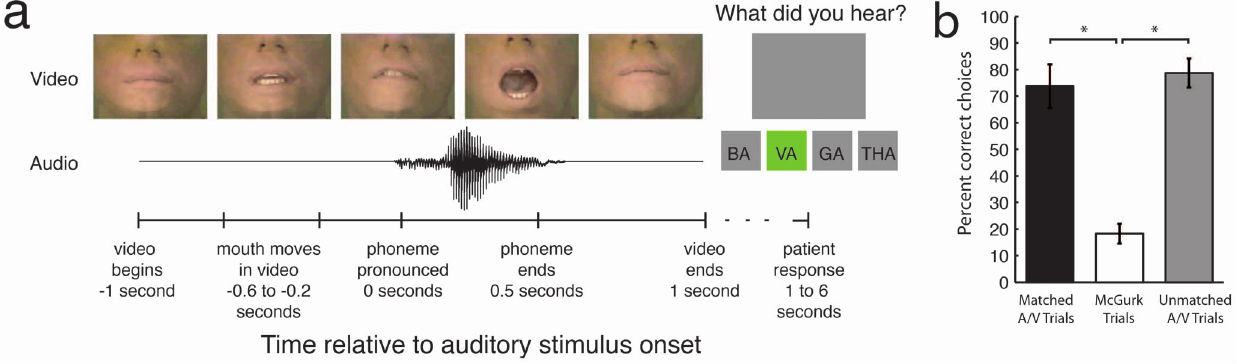
Figure 1. Task description and performance. a, The task consisted of a video of a mouth pronouncing one of four phonemes. This video was randomly paired with audio of a male pronouncing one of the same four syllables. The video times here are shown in the text below the timeline. There was one second of video before the audio began, during which the mouth moved slightly in order to position to speak the starting phoneme. The audio syllable lasted half a second, and there was one second of video after the audio had finished. After a brief randomized delay, the subject was cued to respond. The patient had five seconds to respond before a new trial was initiated. b, Task performance for three conditions. Patients performed significantly better on Matched A/V (73.81%, N=186) trials and Unmatched A/V (78.77%, N=299) trials when compared with McGurk (18.29%, N=152) trials (ANOVA, Tukey-Kramer method for multiple comparisons, p , 0.01 for both comparisons).